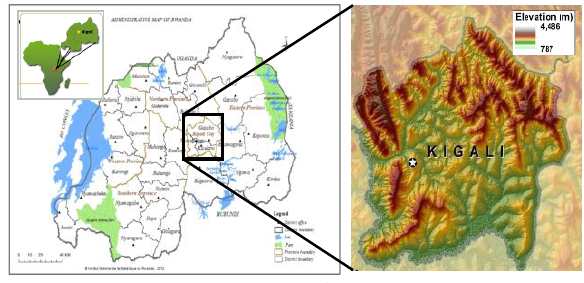
Figure 1: Location of Kigali